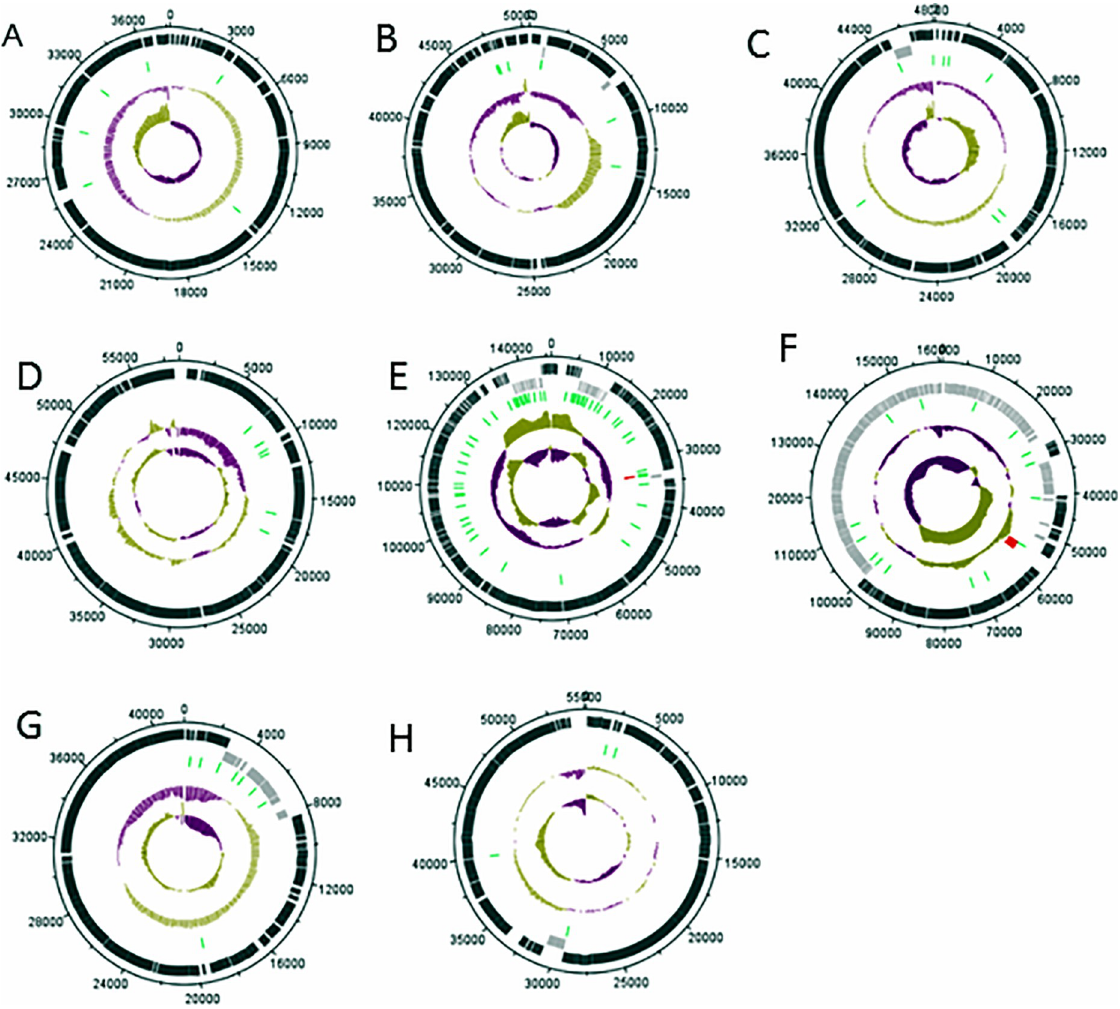
Fig 1. Genome maps drawn to scale, displaying regions and features of interest. A (vB_EauM-23), B (vB_BpsS-36), C (vB_BpsM-61), D (vB_BboS-125), E (vB_EalM-132), F (vB_BcoS-136), G (vB_EalM-137) and H (vB_BpsS-140). First track (black) show forward transcribed ORFs and second track (grey) show reverse transcribed ORFs respectively. Third track (green) show terminators and fourth track (red) show tRNAs. Moving inward, the track show the %GC content (purple = low %GC) and innermost of the genome map GC skew ([G-C]/[G+C]).